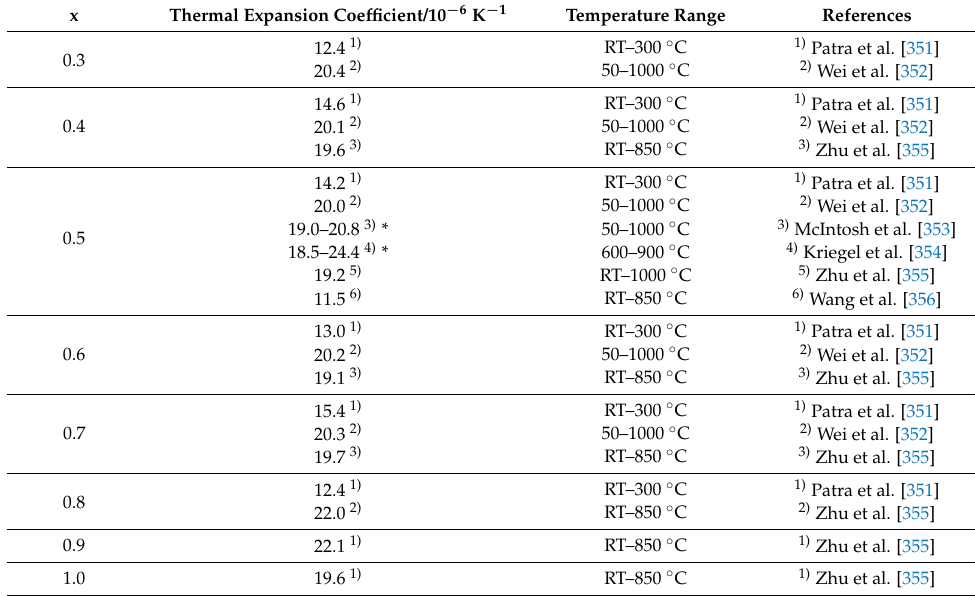
Figure 8. Linear thermal expansion coefficients of Ba 1 − x Sr x Co 0.8 Fe 0.2 O 3 −δ (BSCF) as a function of Sr-content, x. All values are summarized in Table 8 along with the references used. We have used average values for the data by Kriegel et al. [354] and McIntosh et al. [353]. Table 8. Thermal expansion coefficients of Ba 1 − x Sr x Co 0.8 Fe 0.2 O 3 − δ